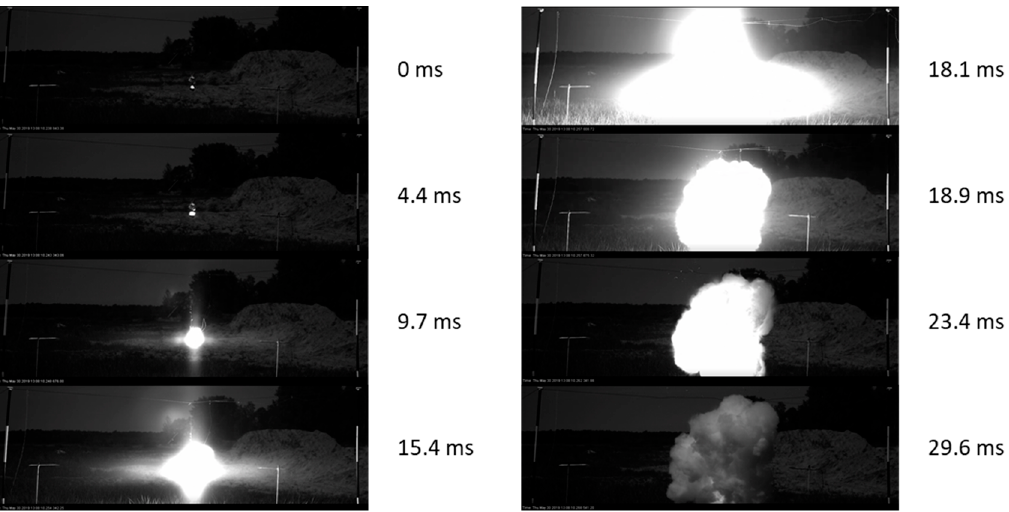
Figure 4. Sequence of images from the 100 g test. The time presented refers to the time after ignition.